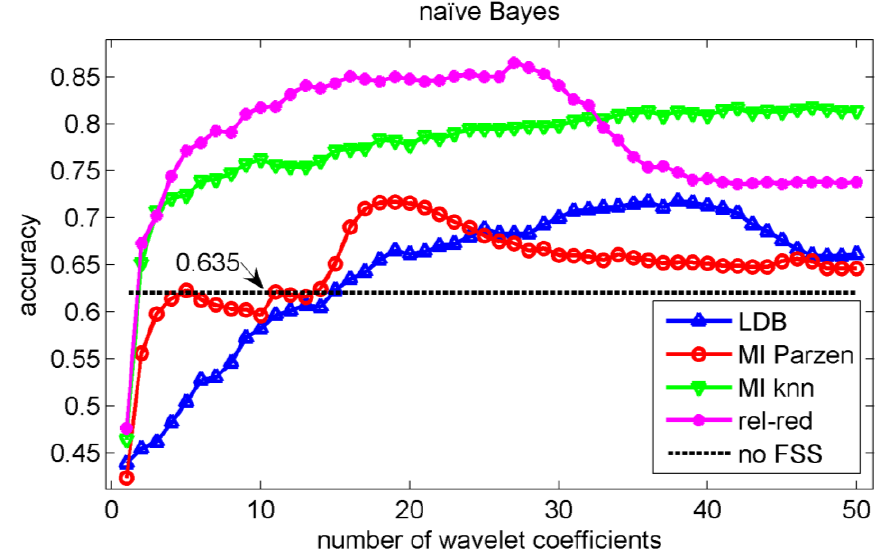
Figure 8. Evolution of the accuracy of naïve Bayes classifier as a function of the number of wavelet coefficients selected with the LDB algorithm and the mutual information filter algorithms. The horizontal line indicates the accuracy when all 1,024 samples are